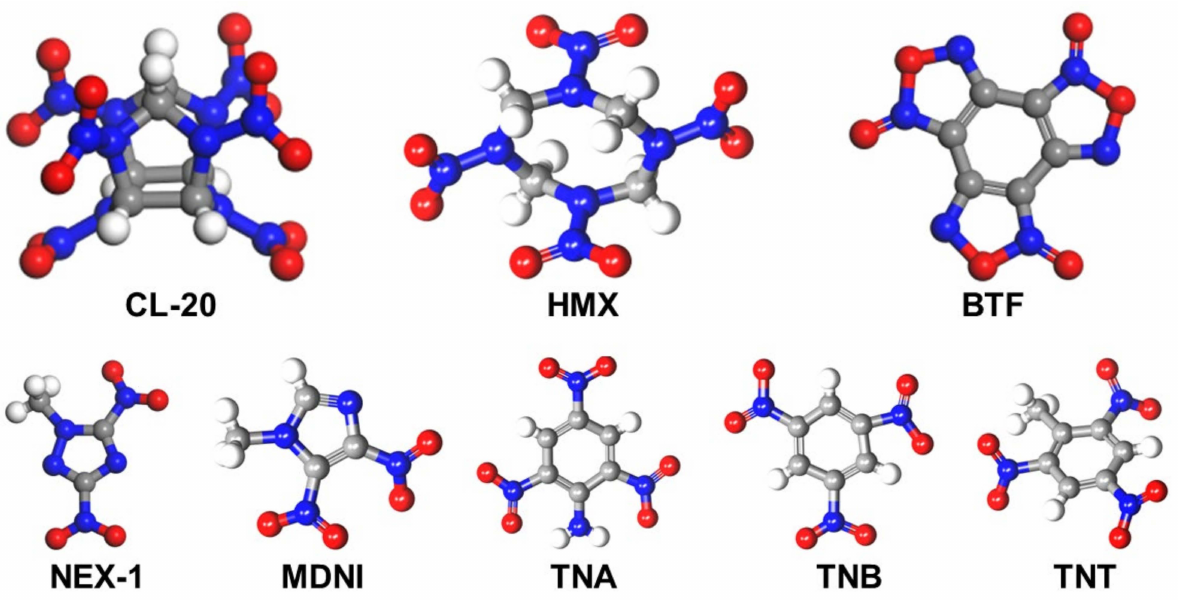
Figure 1. Types of energetic materials and co formers. The carbon, hydrogen, oxygen, and nitrogen atoms are represented in grey, white, red, and blue,